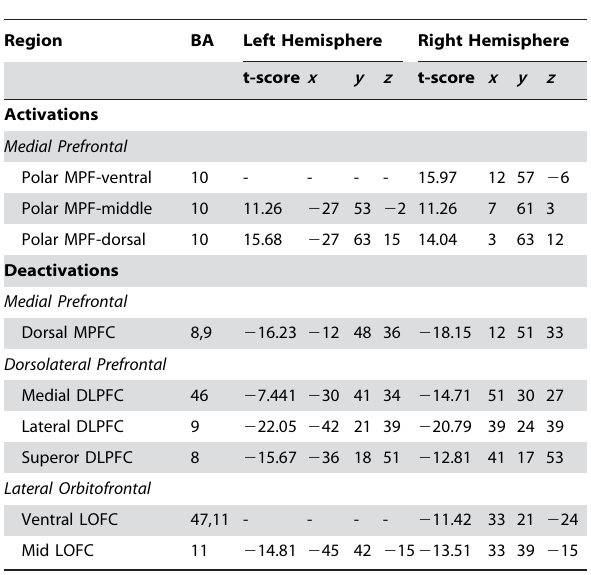
Table 2. Local maxima and minima of brain activations and deactivations within the prefrontal cortex during improvisation.